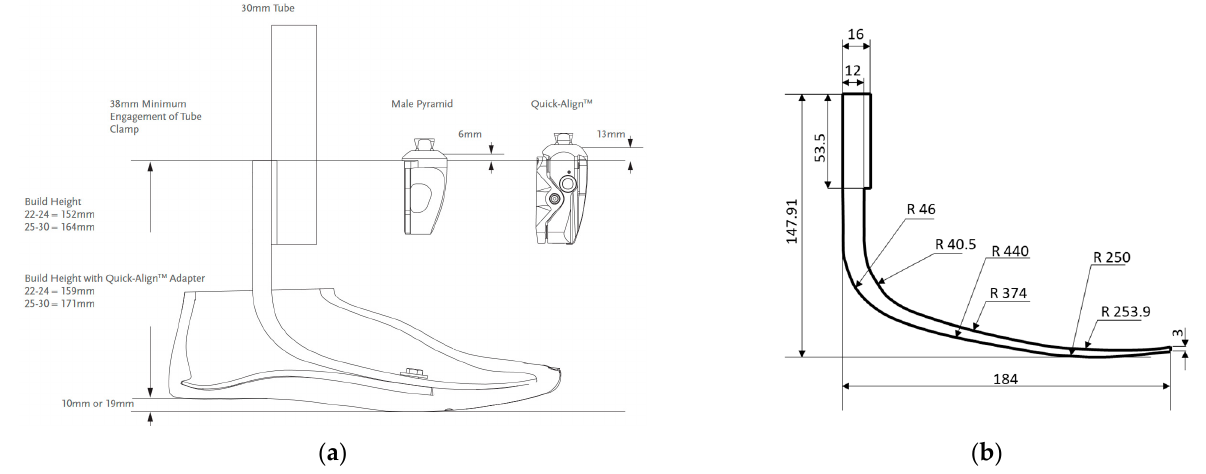
Figure 7. ( a ) The Össur VARI – FLEX TM design taken from [32] and ( b ) the inspired laminated com- ponent.